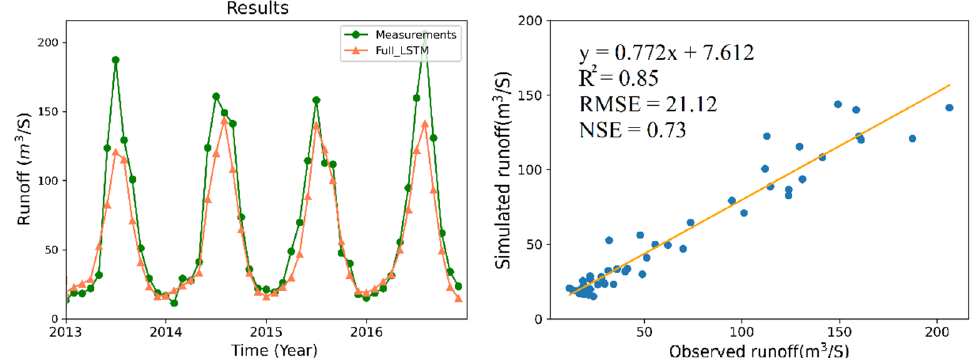
Figure 9. Estimated runoff for the study area derived using the L2 inputs. In the left half, the green and orange broken lines represent the observed runoff and estimated runoff, respectively. On the right side, the orange line indicates the linear regression trendline for observed runoff and simu- lated runoff.